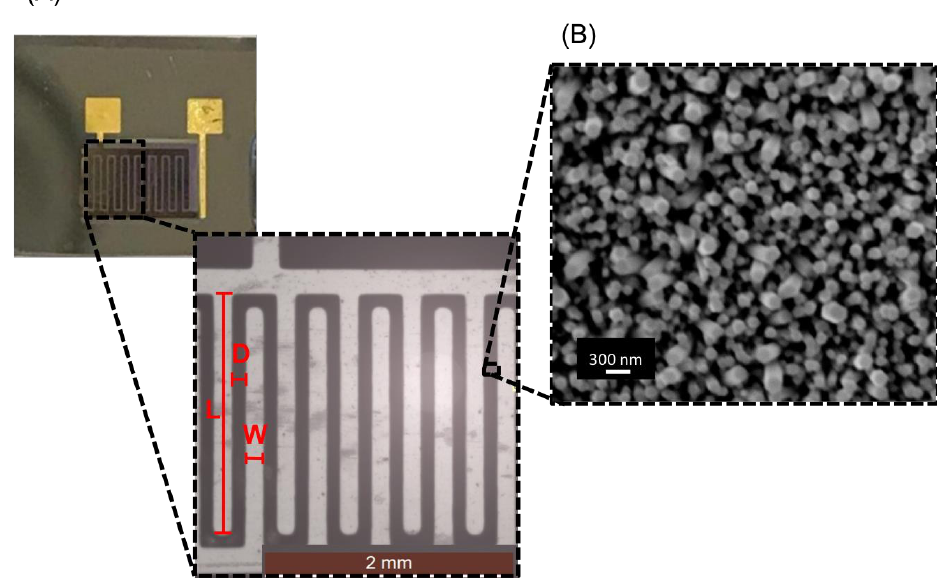
Figure 3. ( A ) Representative images of ZnONW-based electrical sensor. ( B ) SEM image of ZnONWs grown by hydrothermal synthesis.